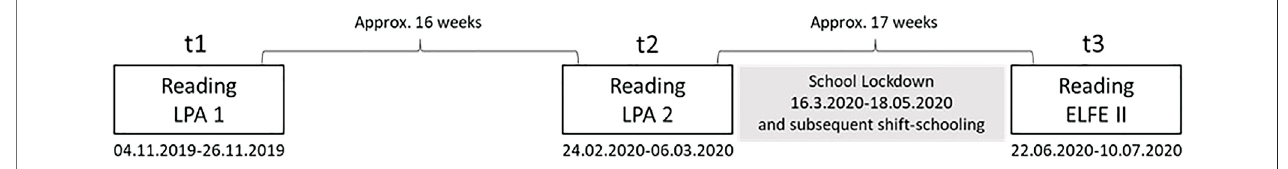
FIGURE 2 | Measurement points of the